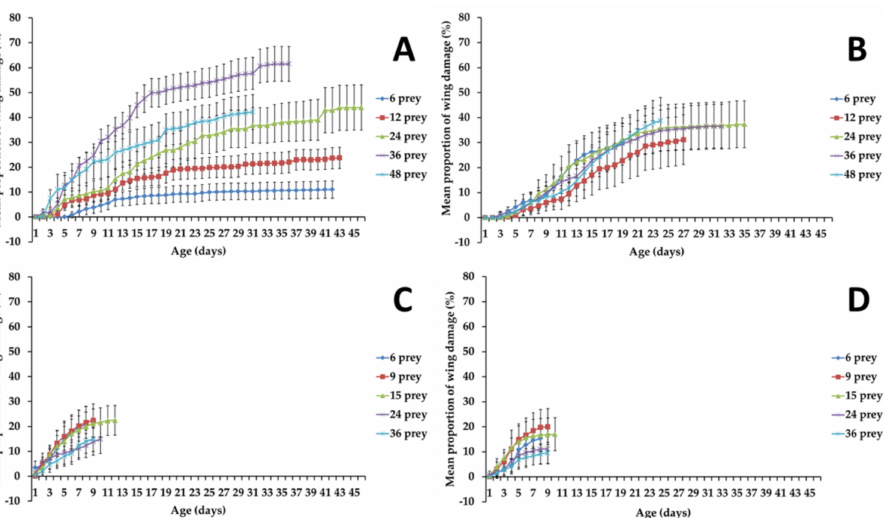
Figure 1. Mean proportion of damaged wings of all Coenosia attenuata when fed different prey at different densities daily per predator adult (mean values with 95% confidence intervals; error bars: 95% CI): ( A ) females fed 6, 12, 24, 36 and 48 adults of Bradysia impatiens ; ( B ) males fed 6, 12, 24, 36 and 48 adults of Bradysia impatiens ; ( C ) females fed 6, 9, 15, 24 and 36 adults of Drosophila melanogaster ; ( D ) males fed 6, 9, 15, 24 and 36 adults of Drosophila melanogaster . Females and males of C. attenuata had much shorter longevity when fed D. melanogaster adults compared to those fed B. impatiens adults (maximum age of 12 for D.